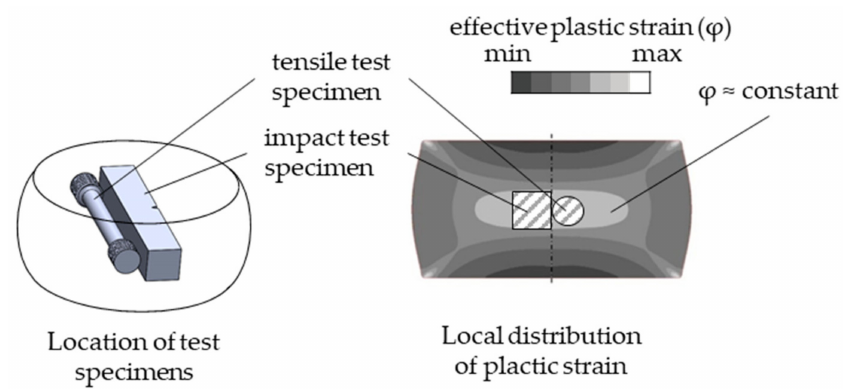
Figure 3. Formed component with distribution of plastic strain (schematically) and position of test